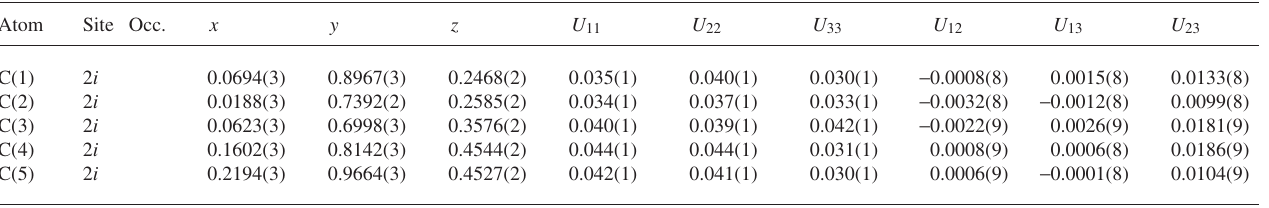
Table 3. Atomic coordinates and displacement parameters (in Å 2 ) . Atom Site